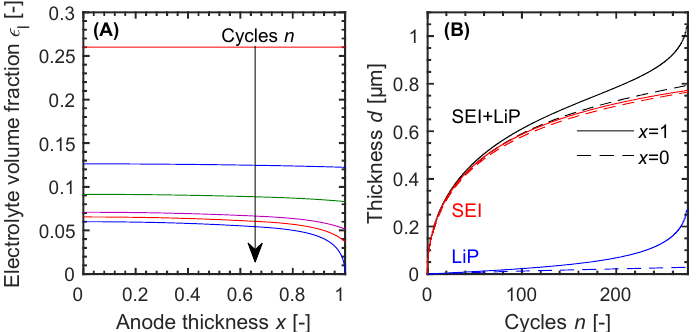
Figure 4. Results for the cell with constant initial anode porosity. ( A ) Electrolyte volume fraction across the thickness of the anode after n = 0,75,150,225,250 and 275 cycles. ( B ) Thickness of the surface layer at the current collector ( x = 0, dashed) and the separator side ( x = 1, solid) as well as the equivalent thicknesses of pure layers separately. The formation of SEI is homogeneous across the anode and the rate is reducing over time while lithium plating is responsible for the difference in layer thickness towards the EoL.